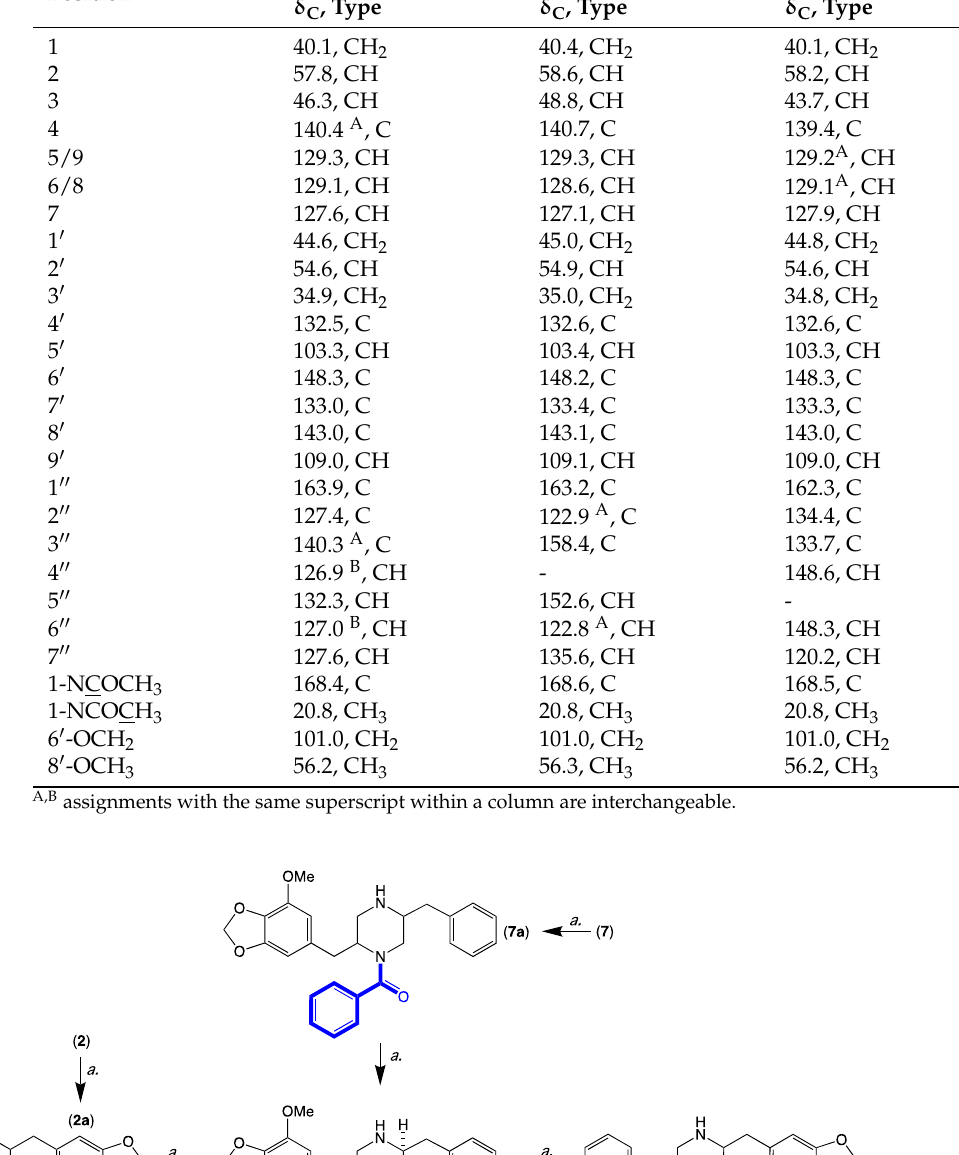
Table 2. 13 C NMR (DMSO- d 6 ) data for 1 , 3 and 5 . Position